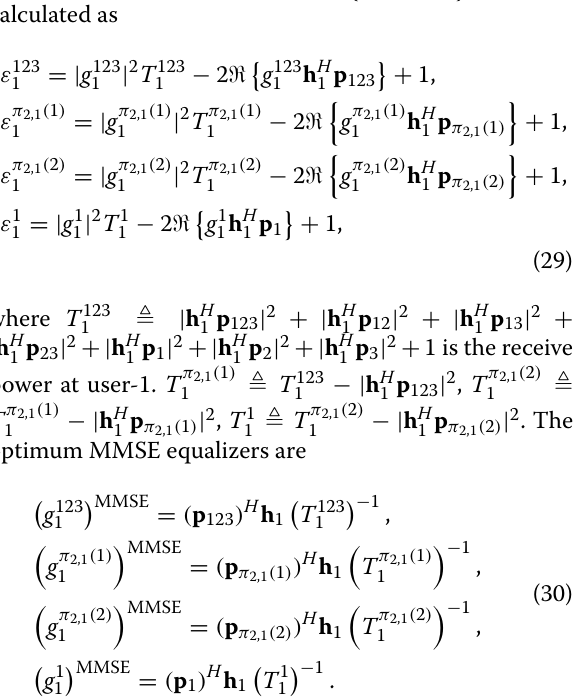
Encode K + 1 plus additional common streams